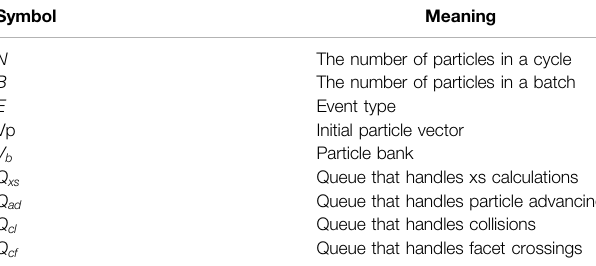
TABLE 1 | Summary of